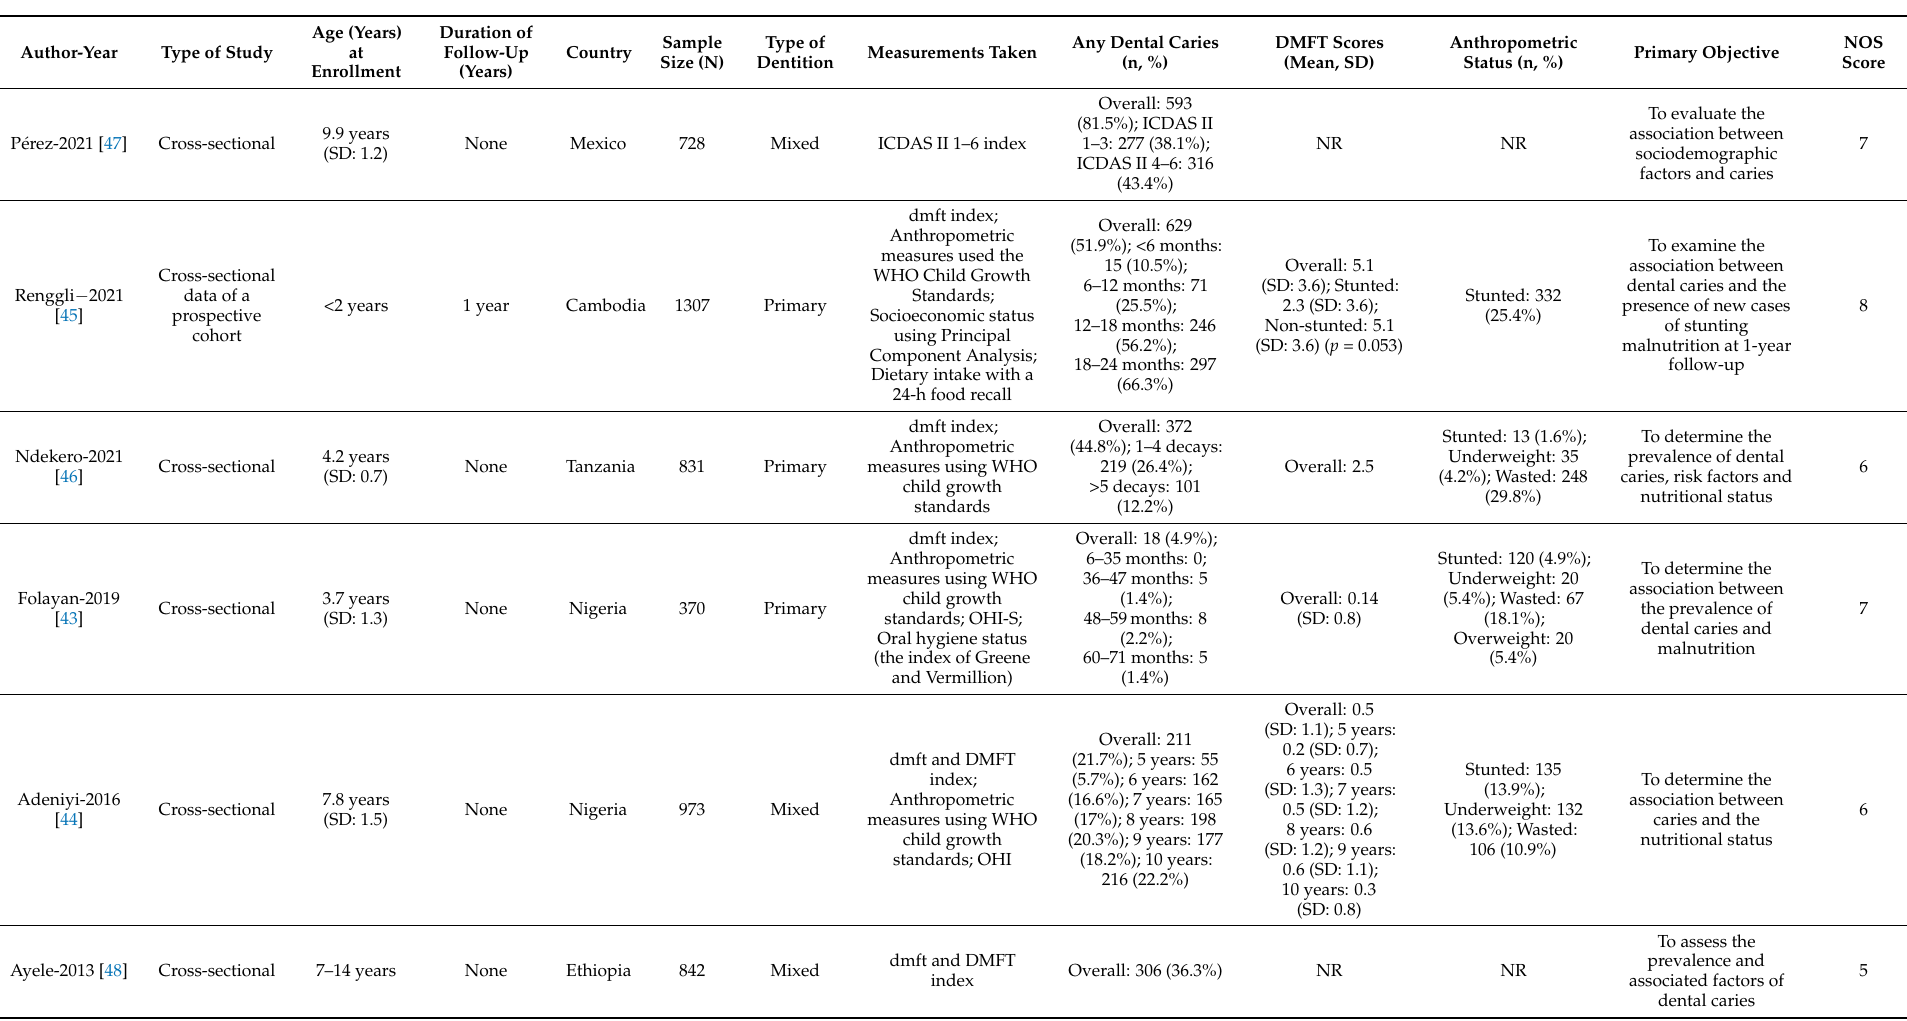
Table 1. Baseline characteristics of the